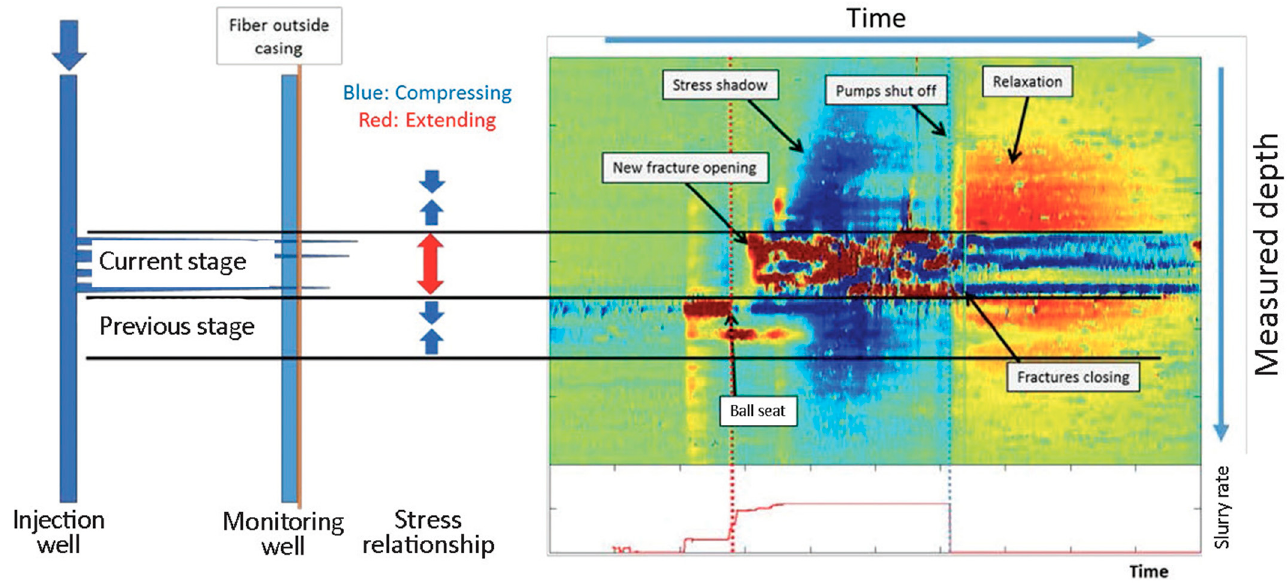
Figure 12. Low-frequency DAS recording of fractures and pressure fronts interacting with a fiber in an offset well. Events of interest are labeled. Figure from Jin and Roy (2017), The Leading Edge.